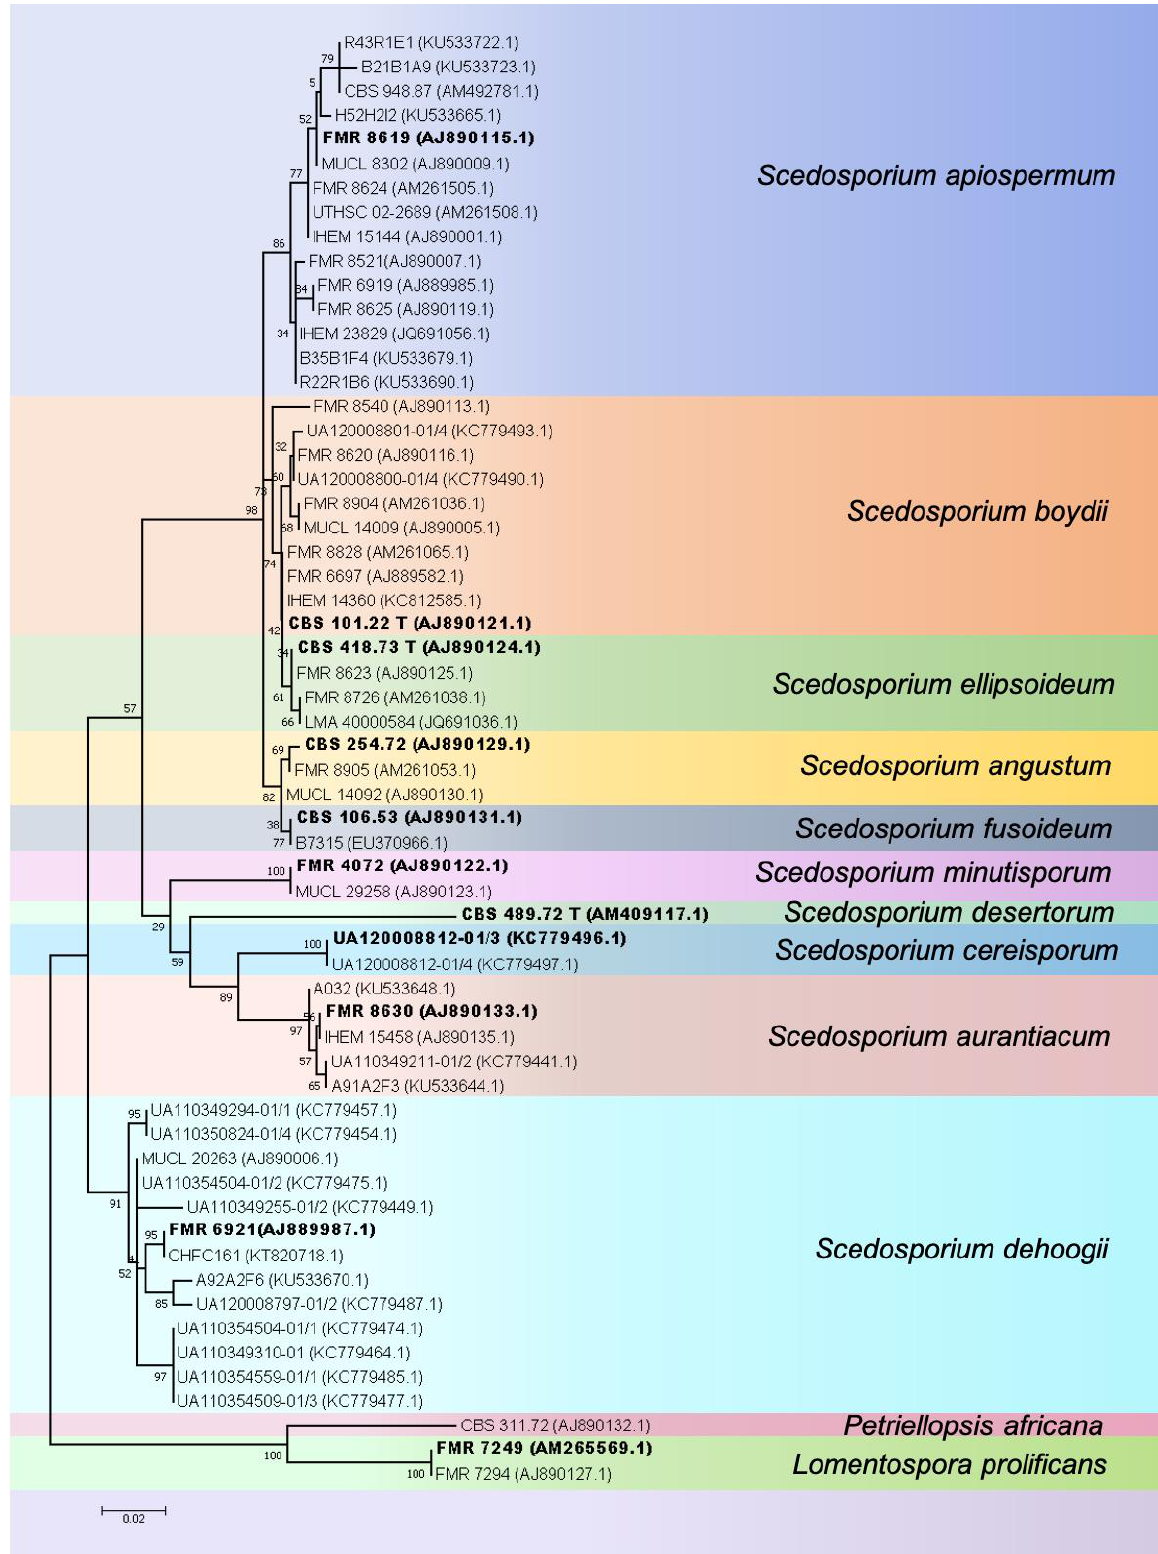
Figure 1. Phylogenetic tree of Scedosporium species based on 60 tubulin sequences ( TUB , exon 5 and 6), representing the known genetic variation within the genus, using Maximum Likelihood with the K2+G model and 500 bootstrap replications. Bootstrap values >50 are given. The tree is rooted with the outgroup species Petriellopsis africana and Lomentospora prolificans . GenBank accession numbers are given in brackets behind the strain numbers. Bold font indicates sequences of type